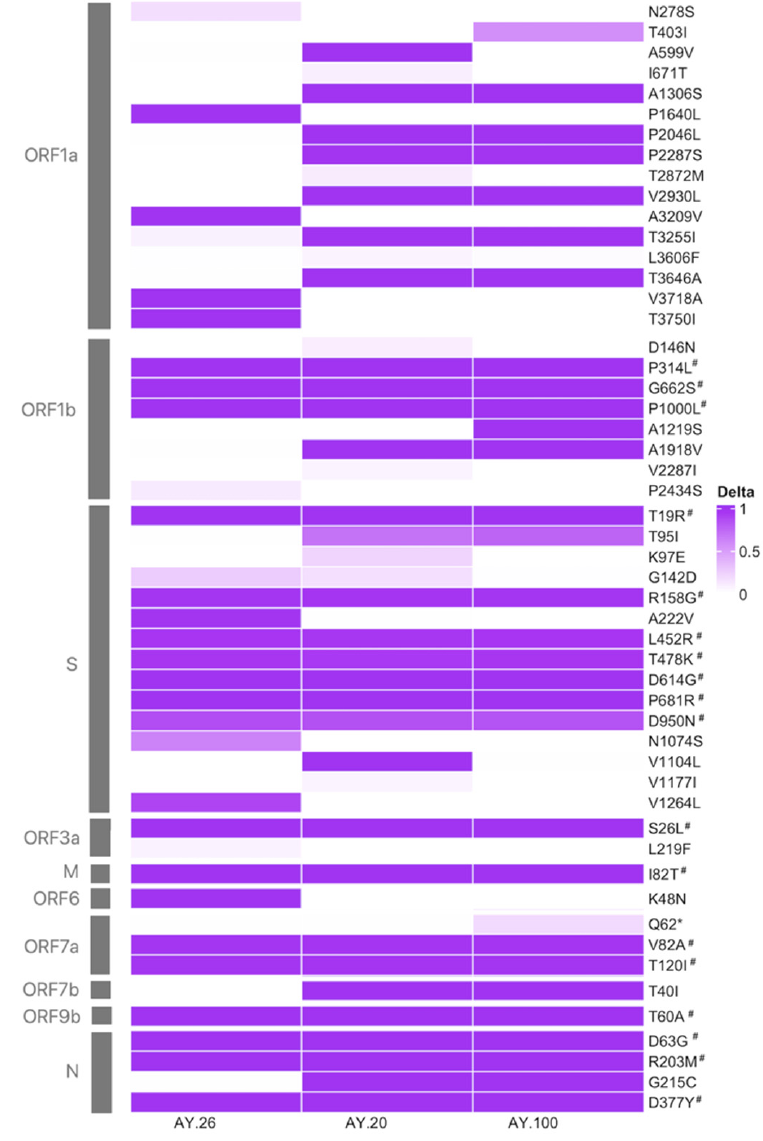
Figure 3. Frequency of aa changes in SARS-CoV-2 genome sequences of Mexico compared with the Wuhan reference genome (NC_045512). Only changes above 5% prevalence in at least one of the sublineages are shown. * Denotes an stop codon. The Delta-defining substitutions are marked with #.